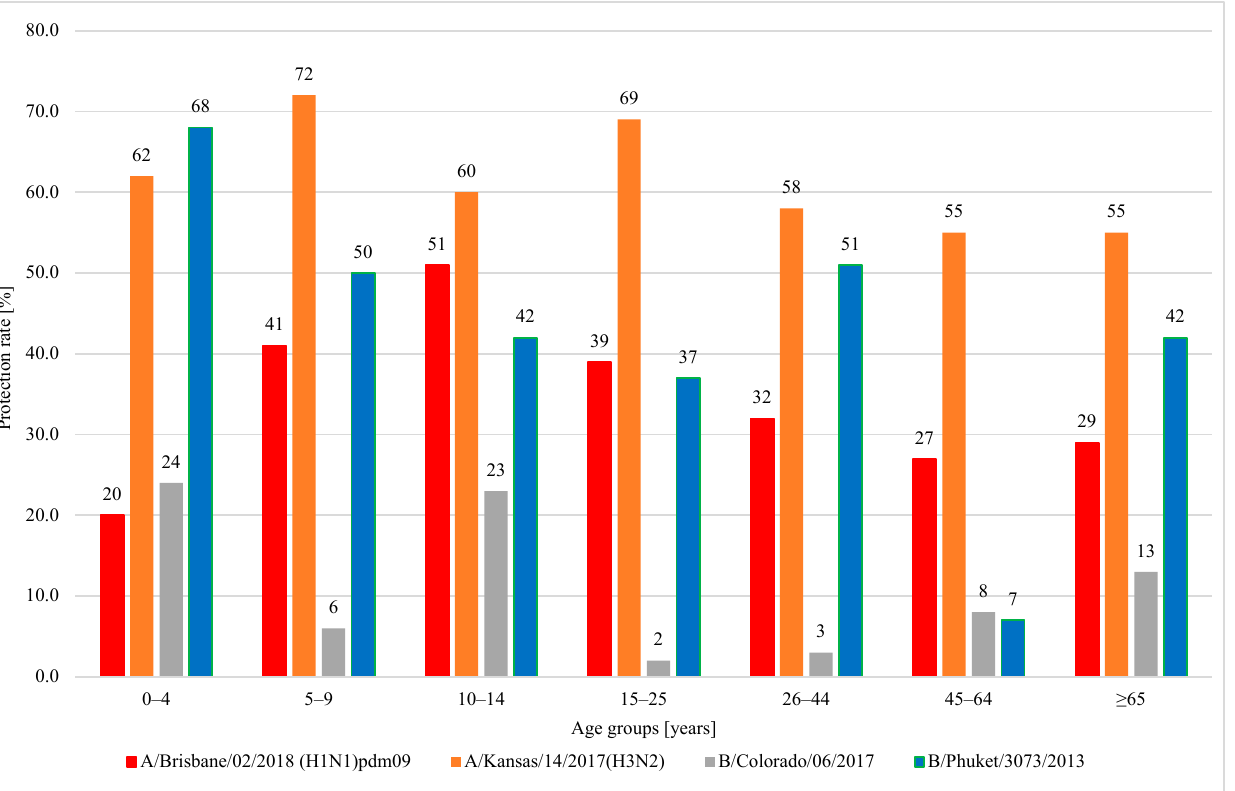
Figure 4. Percentage of cases with a protective titer of anti-haemagglutinin antibodies (%) in the 2019/2020 epidemic season in di ff erent age groups.